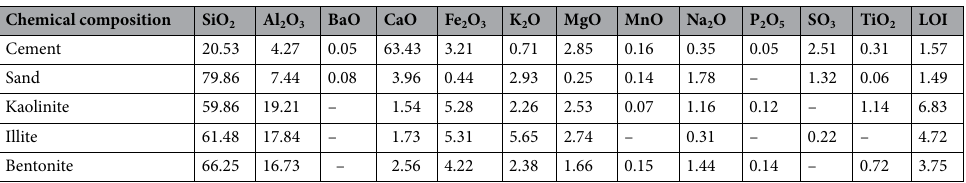
Table 1. XRF analysis of cement, sand grains, and clays used for preparing core sample (%).